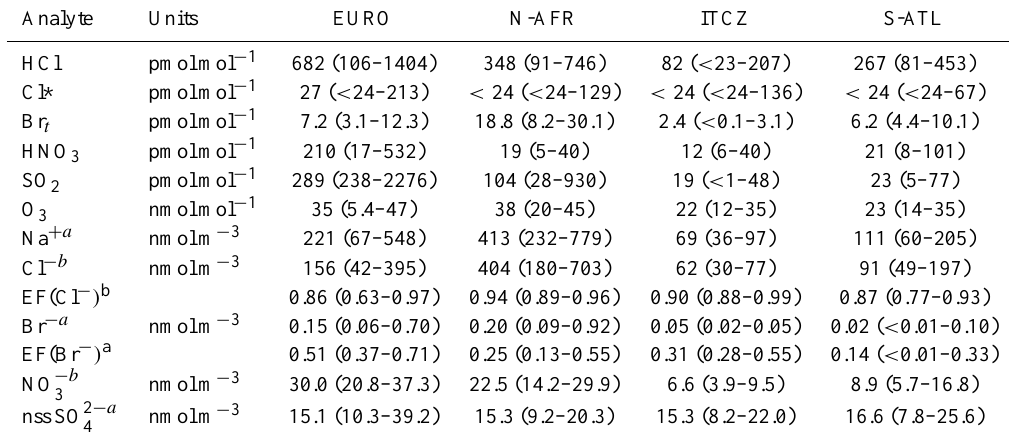
Table 3. Median values and ranges (in parentheses) for measured characteristics in each regime.